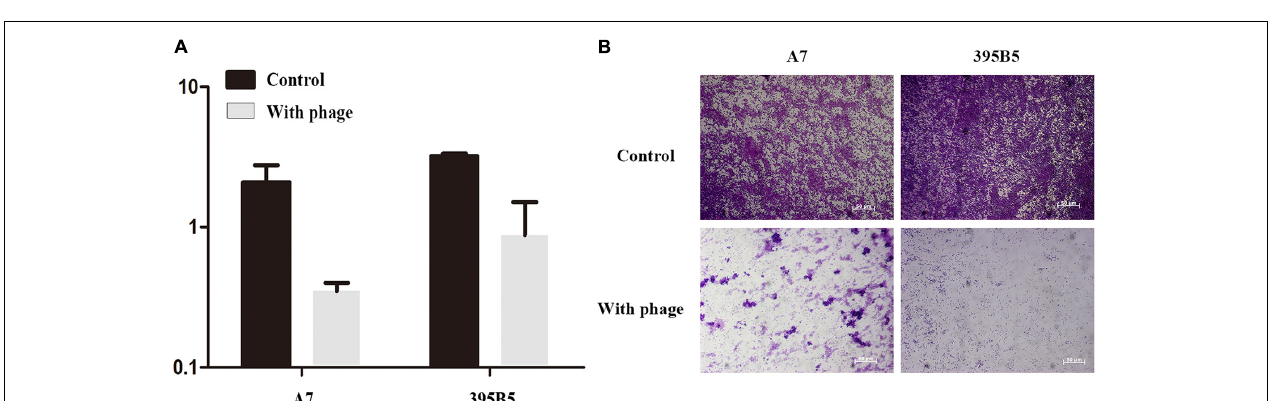
FIGURE 7 | Crystal violet assay showing the biofilm biomass of Shiglla flexneri A7 and E. coli 395B5 grown in the presence or absence of phage vB_ShiP-A7. (A) We measured optical density readings in replicates to evaluate the inhibition of biofilm by phage vB_ShiP-A7. (B) The 2 above pictures are Shiglla flexneri A7 strain and E. coli 395B5 strain without phage; The bottom 2 pictures are Shiglla flexneri A7 and E. coli 395B5 exposured to phage vB_ShiP-A7.